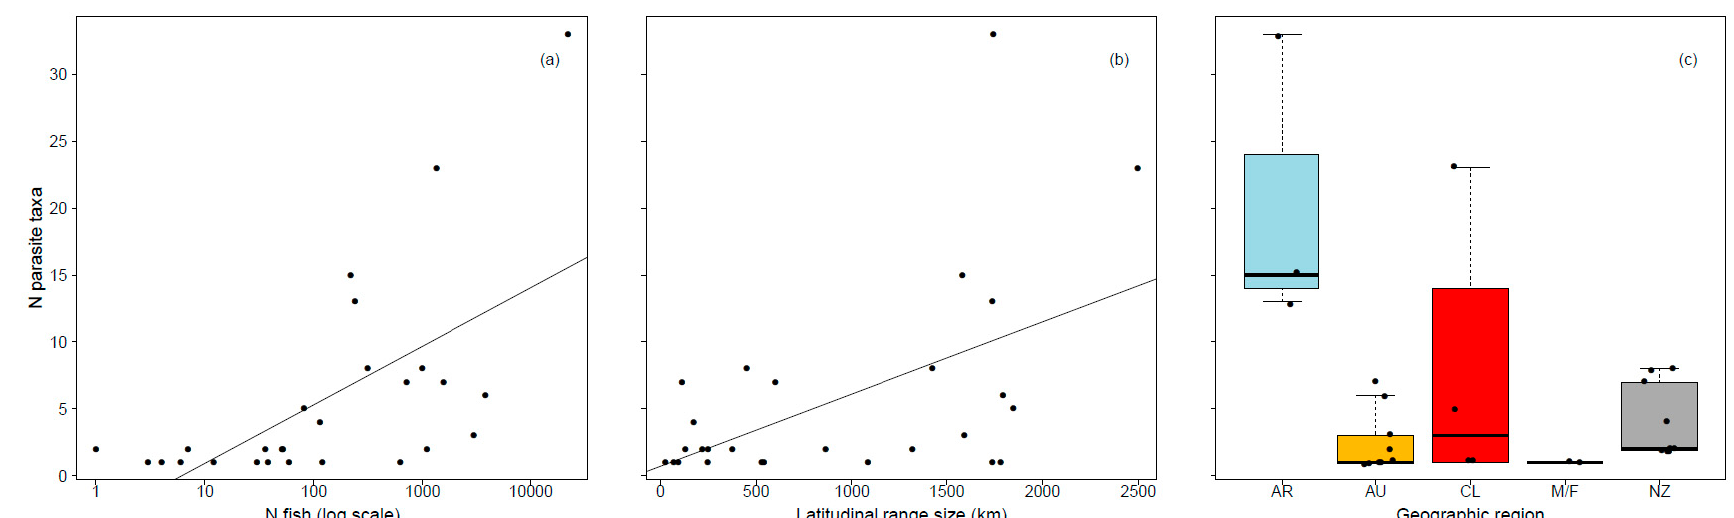
Figure 3. Influence of the ( a ) number of fish (log scale), ( b ) latitudinal range size (km), and ( c ) geographic region on the number of parasite taxa reported in galaxiid fishes (AR Argentina, AU Australia, CL Chile, M/F Islas Malvinas/Falkland Islands, NZ New Zealand).